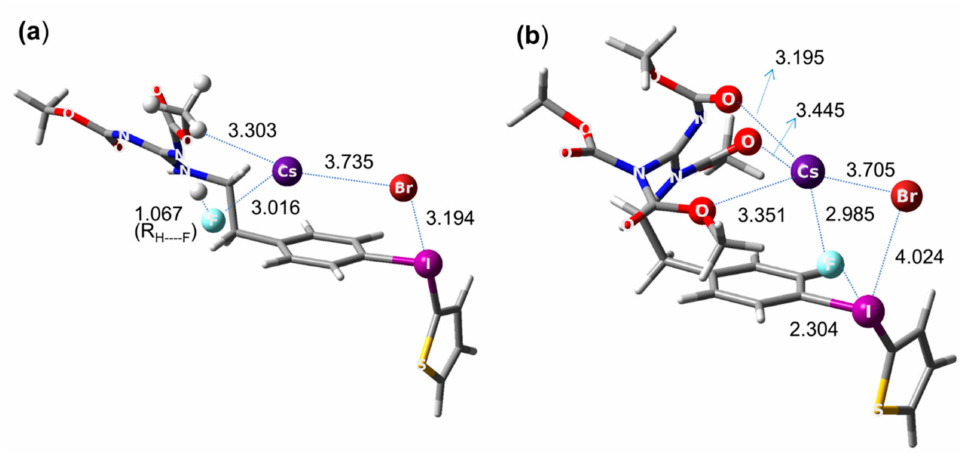
Figure 6. Pre-reaction complexes for reactions listed in Scheme 2. In ( a ) the absence of hydrogen bonding positions F − favorable for fluorination, whereas in ( b ) hydrogen bonding with -NHR moves F − far o ff the reaction center. M06-2X / 6-311G ** method for C, H, O, N, F, S atoms, LANL2DZ basis set with relevant e ff ective core potential for alkali metal elements (I, Br, Cs), using Gaussian 09 set of